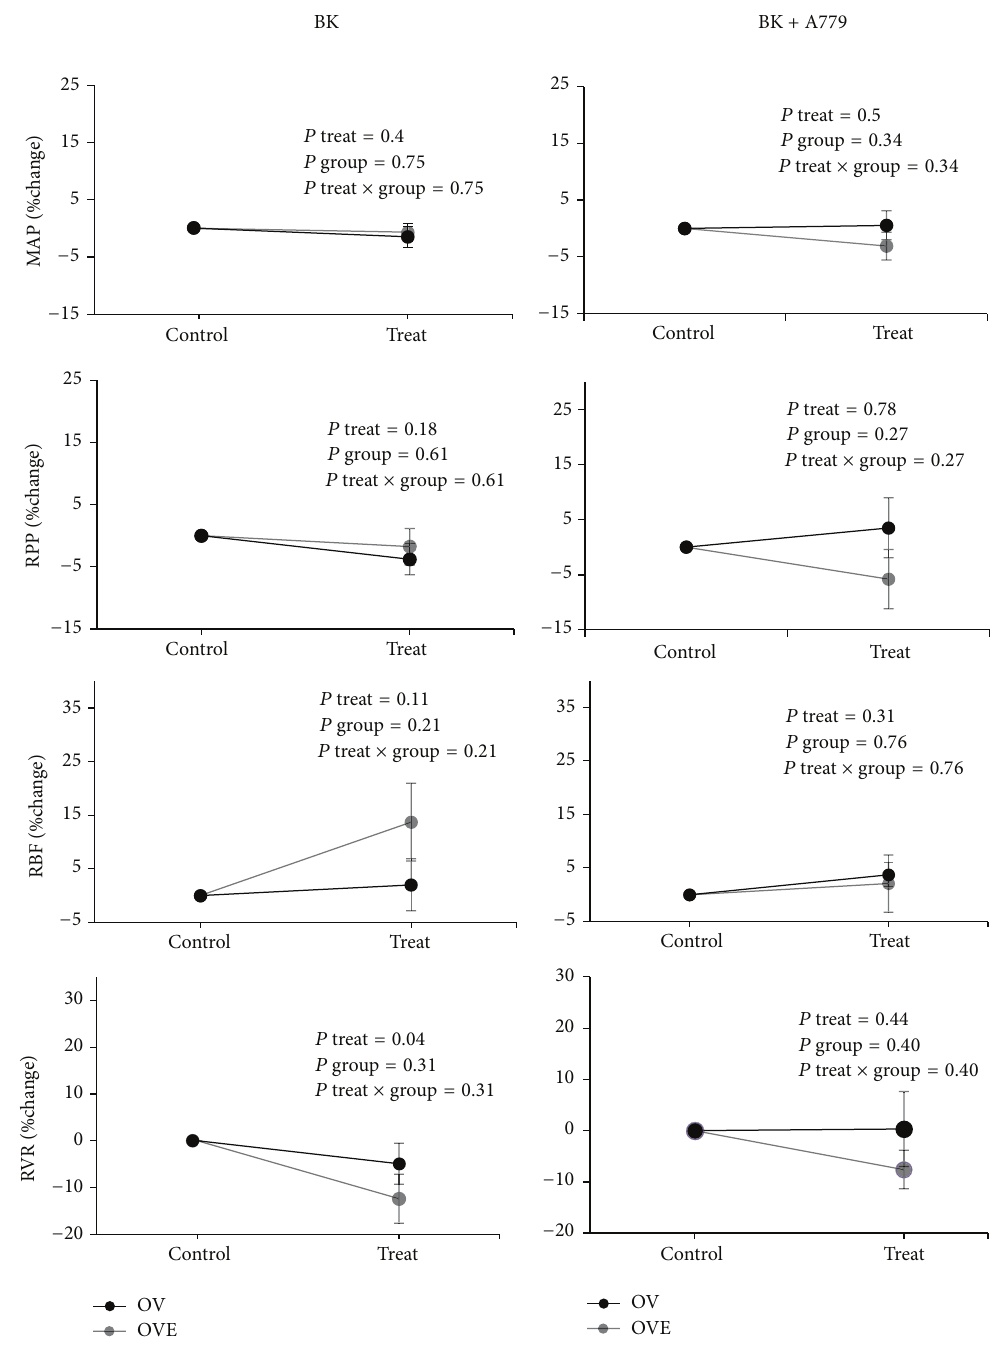
Figure 2: Parameters were recorded in ovariectomized and ovariectomized estradiol-treated rats before and after administration of BK or A779 + BK. Data are presented as mean ± SEM of percentage changes from the baseline. MAP, mean arterial pressure; RPP, renal perfusion pressure; RVR, renal vascular resistance; RBF, renal blood flow per gram kidney weight. P values were derived from repeated measures